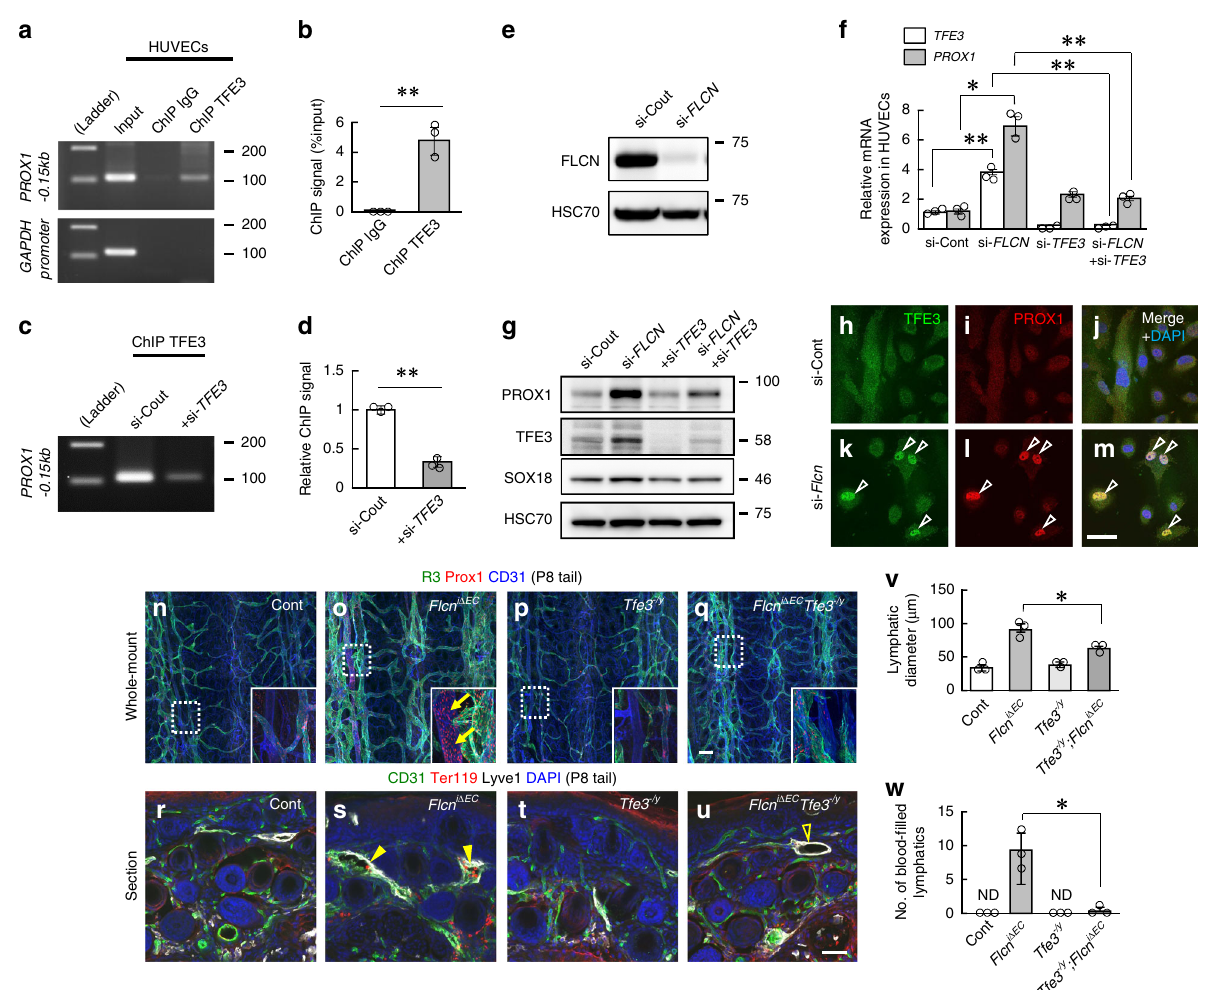
Fig. 6 Flcn suppresses Prox1 expression through Tfe3. a, b ChIP analysis of HUVECs to measure/quantify binding of endogenous TFE3 to PROX1-0.15 kb ( n = 3). c – d ChIP analysis of HUVECs treated with or without si- TFE3 and quanti fi cation ( n = 3). e Western blotting of HUVECs treated with or without si- FLCN . f Quantitative PCR analysis ( n = 3) of HUVECs treated with si- FLCN with or without si- TFE3 . g Western blotting of HUVECs treated with si- FLCN with or without si- TFE3 . h – m Immunocytochemistry of HUVECs. PROX1 + cells largely correspond to TFE3 + cells (arrowheads). n – w Immunohistochemical analysis of tail whole mounts ( n – q ) or sections ( r – u ) at P8 and quanti fi cation ( n = 3). Venous Prox1 expression (arrows) and blood- fi lled lymphatics (closed arrowheads) are detected in Flcn i Δ EC mice. Hyperplastic LVs in Flcn i Δ EC Tfe3 -/y are not blood- fi lled (open arrowhead). Scale bars: 200 µ m ( n – q ); 50 µ m ( h – m, r – u ). The comparisons between the averages of the two groups were evaluated using the two-sided Student ’ s t -test. ** P < 0.01; * P < 0.05; ND Data fi